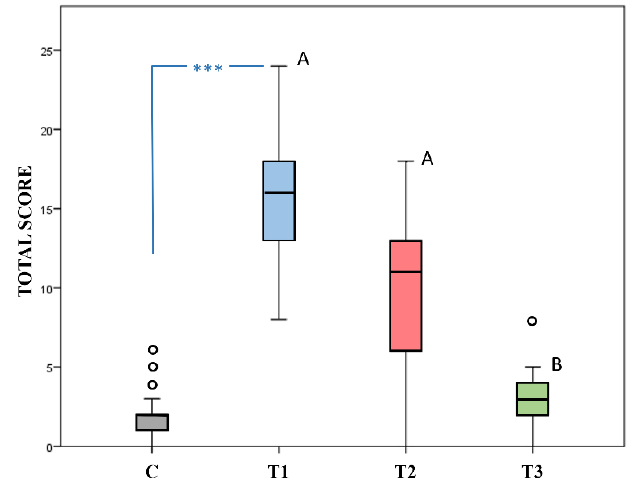
Figure 2. FCPS Total scores recorded in 35 healthy pain-free foals (Control Group = C) and in 15 sick foals experiencing pain at three different time points (T1: at inclusion in the study; T2: after anti-inflammatory drugs; T3: at recovery). The presence of *** indicates a significant difference between groups at inclusion (C vs. T1, Mann Whitney U test p < 0.001). Different superscript letters (A, B) indicate a significant difference ( p < 0.001) between time points (Tukey’s test, T3 vs. T2, T1). Outliers are shown as dots °.